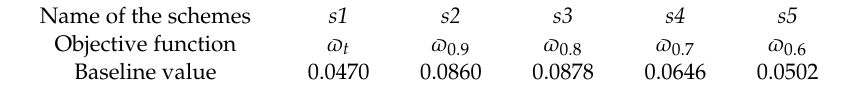
Table 3. Names of optimization schemes for each objective function and the baseline values (CFD). Name of the